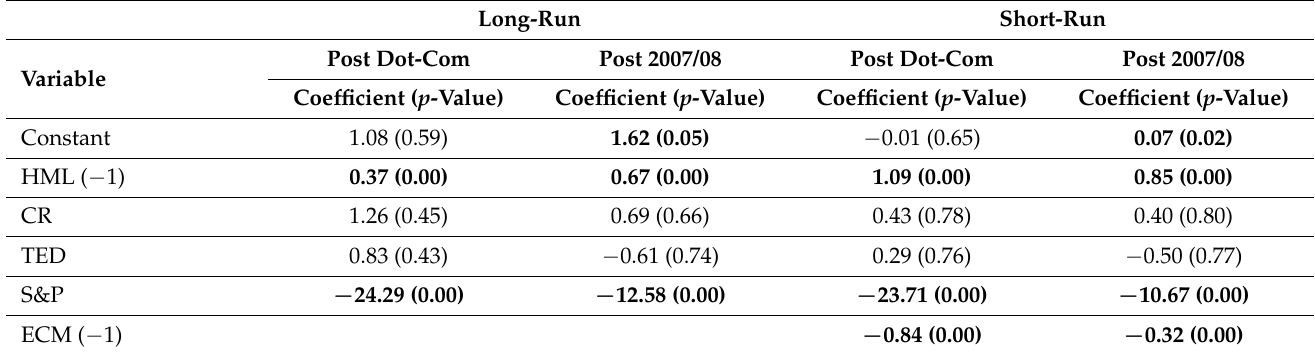
Table 19. Long-run ARDL model and short-run error correction model for HML (Non-Recession).